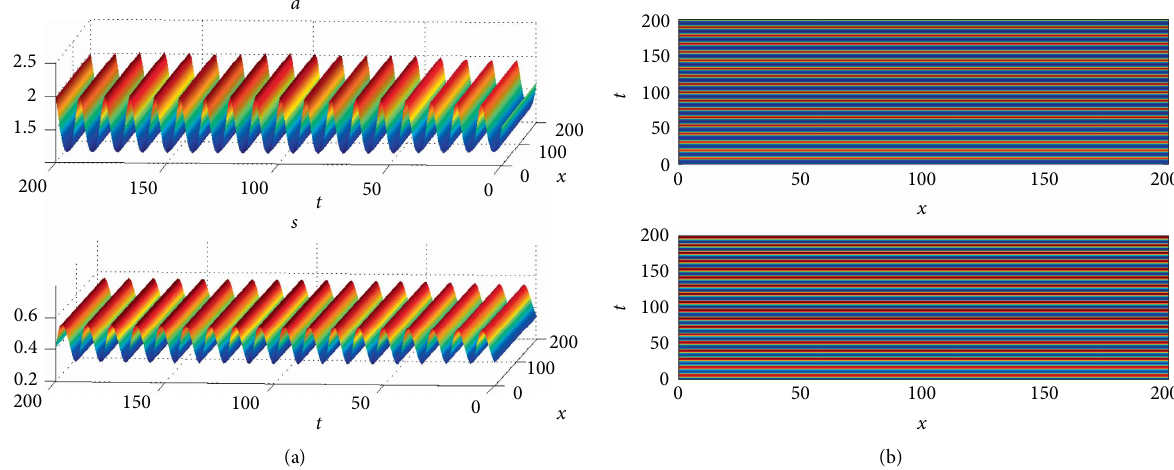
Figure 5: (a) The stable limit cycle of (4) is still stable for (3) for coordinates.